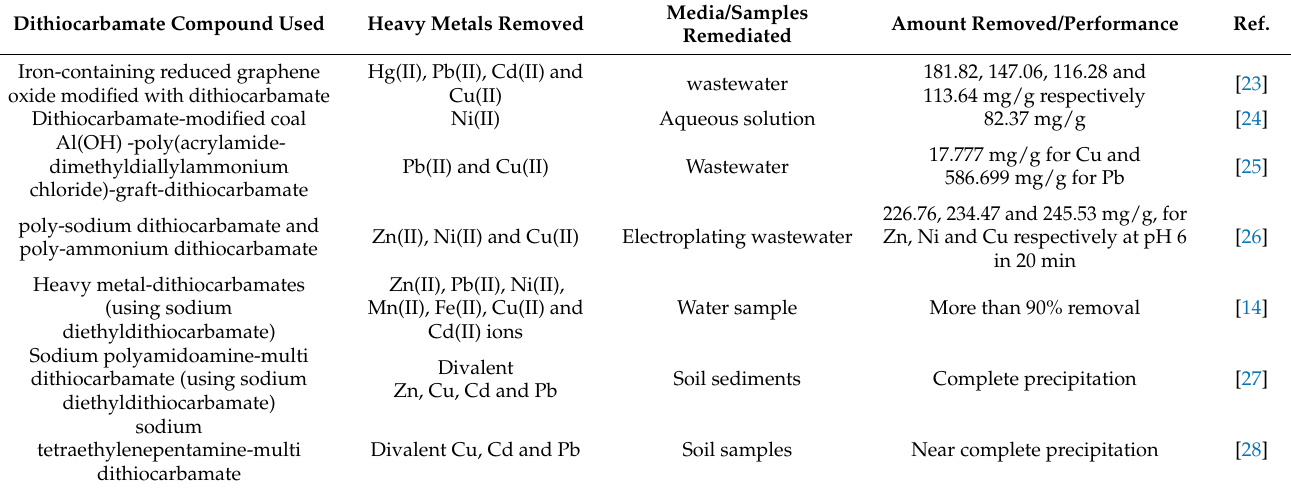
Table 1. Heavy metals remediation via